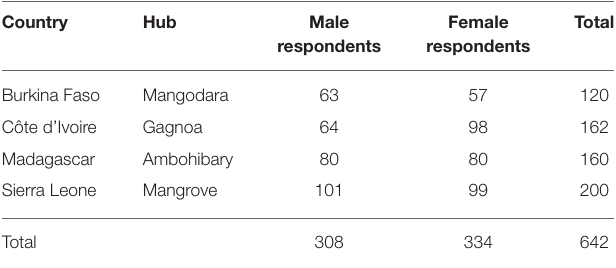
TABLE 1 | Sampling of male and female respondents in Burkina Faso, Côte d’Ivoire, Madagascar, and Sierra Leone.